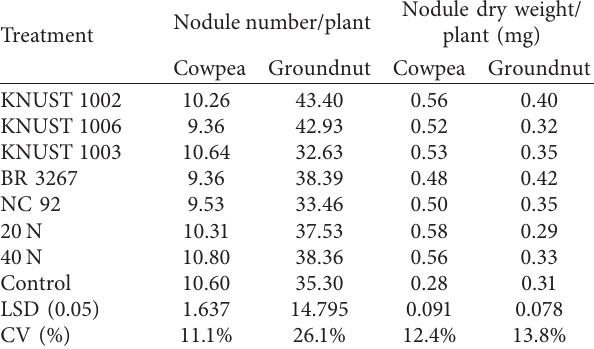
Table 2: Influence of rhizobial inoculation and N fertilizer ap- plication on nodule number per plant and nodule dry weight/plant of cowpea and groundnut grown at Nyankpala in the Guinea Savanna zone of Ghana. Response of rhizobial inoculation on cowpea and groundnut pod yield.